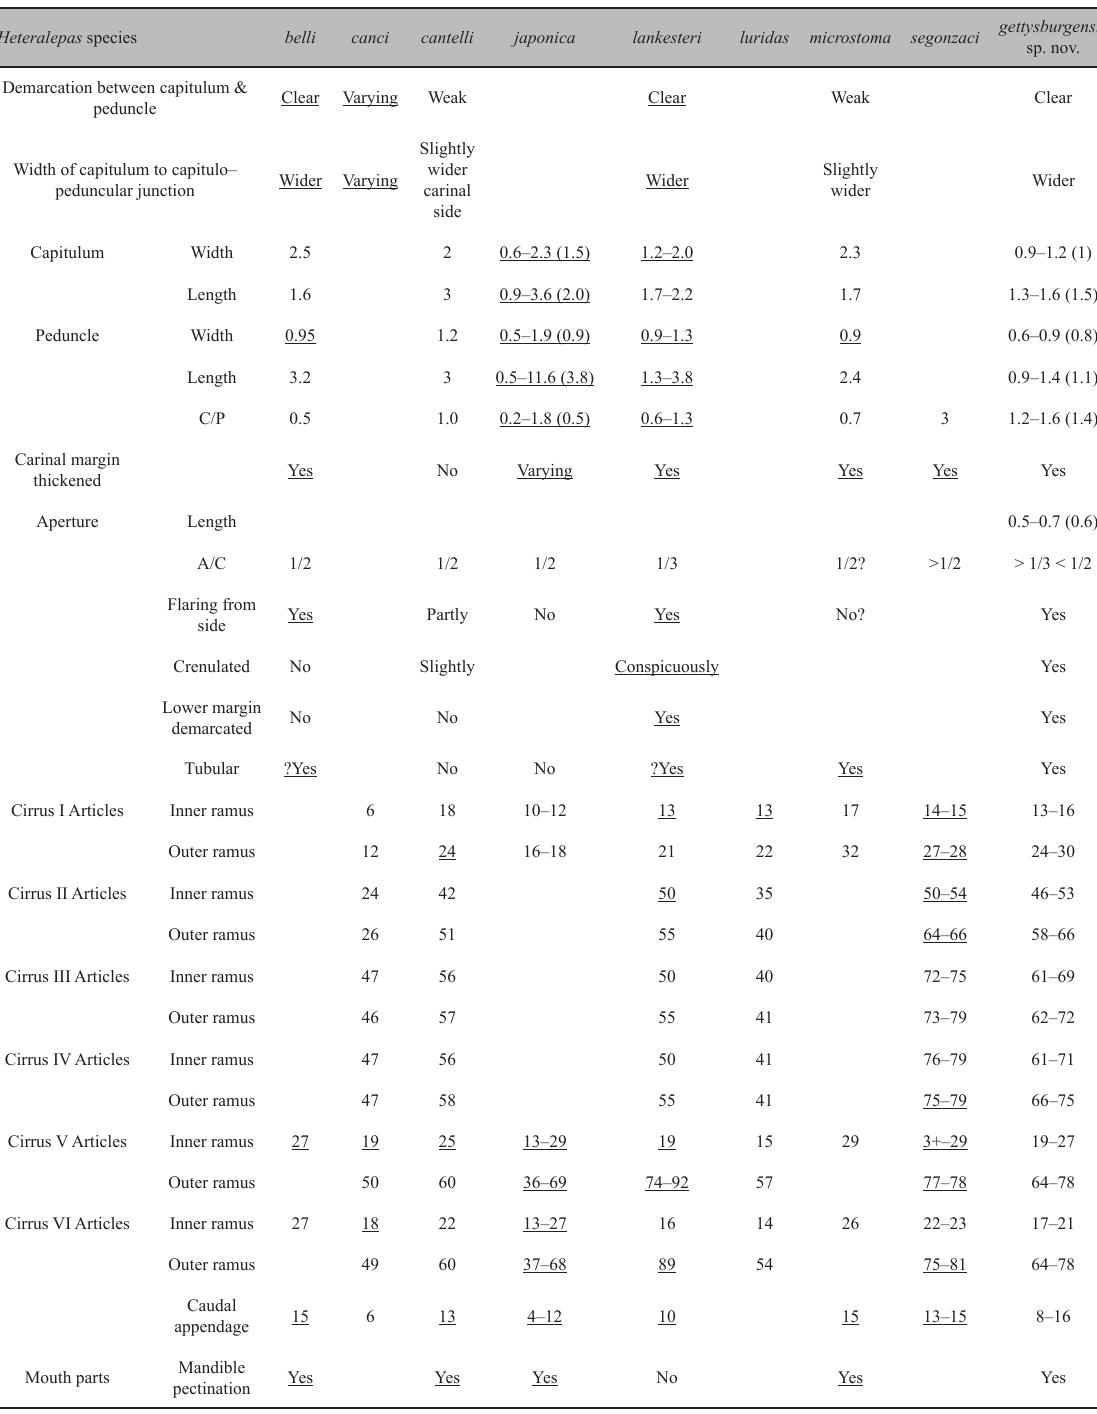
Table 2. Comparison of diagnostic characters between the new species H. gettysburgensis sp. nov. and H. belli (Gruvel, 1902), H. canci Chan, Tsang & Shih, 2012, H. cantelli Buhl-Mortensen & Newman, 2004, H. japonica Aurivillius, 1892, H. lankesteri (Gruvel, 1900), H. microstoma (Gruvel, 1901) and H. segonzaci Young, 2001. The table was based on Buhl-Mortensen & Newman (2004). C/P = Ratio of length of capitulum (C) to length of peduncle (P); A/C = Ratio of height of aperture (A) to height of capitulum (C). Characters coincident with the new species are